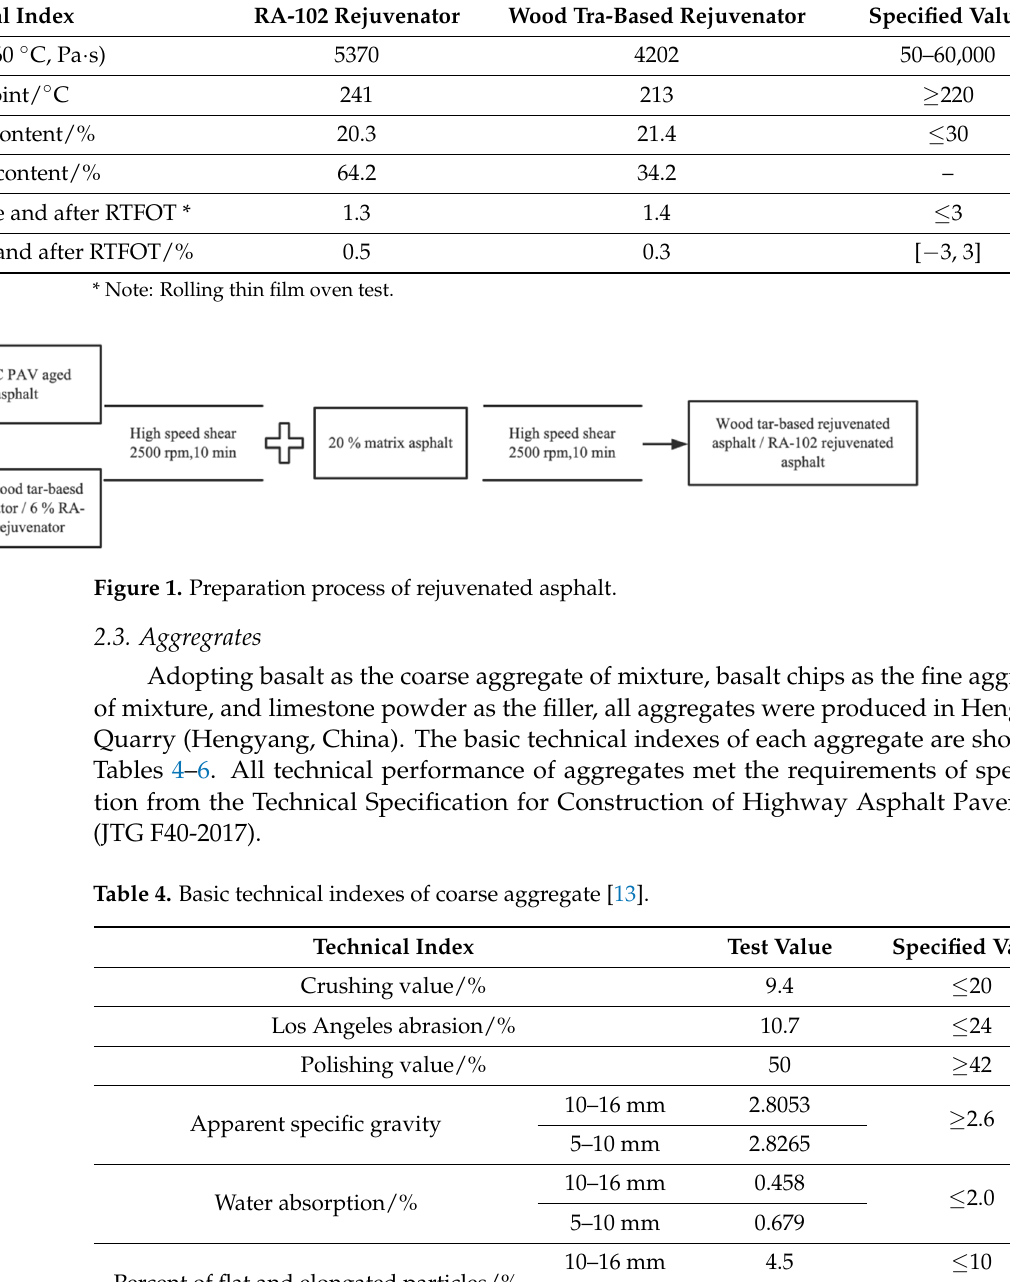
Table 5. Basic technical indexes of fine aggregate [13].